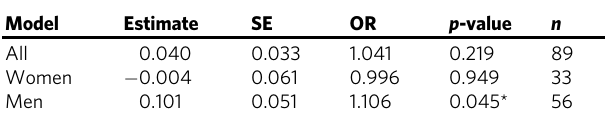
Analyses are adjusted for DCSI (T0), chronological age (T0), sex (if applicable), smoking (packyears, T0), alcoholconsumption (g/d,T0), antidiabeticmedication (yes/no, T0), and BMI (T0). Included are all participants with diagnosed T2D at baseline. T0 baseline, SE standard error, OR odds ratio. * p